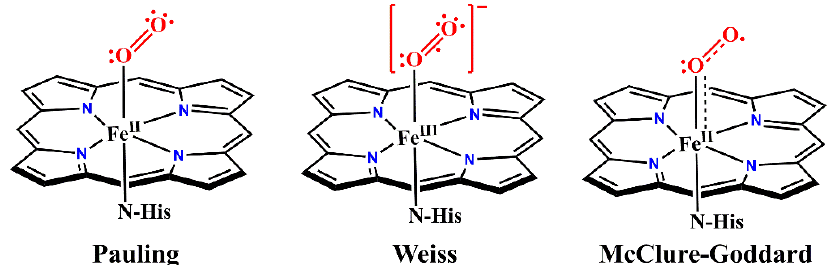
Figure 2. Three models of the iron–dioxygen bond. Pauling model: Low-spin ( S = 0) Fe II with singlet O 2 ; Weiss model: Low-spin ( S = 1/2) Fe III antiferromagnetically coupled to an O 2• − ; McClure-Goddard model (ozone model): Intermediate-spin ( S = 1) Fe II antiferromagnetically coupled to triplet O 2 . Reprinted with permission from Ref. [45]. Copyright 2013 American Chemical Society.